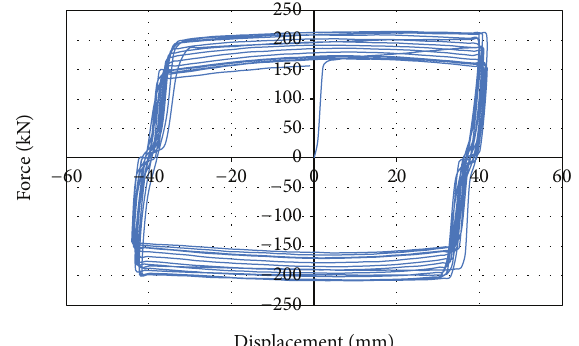
Figure 6: Experimental hysteretic force-displacement curve of the original CFD (case C).